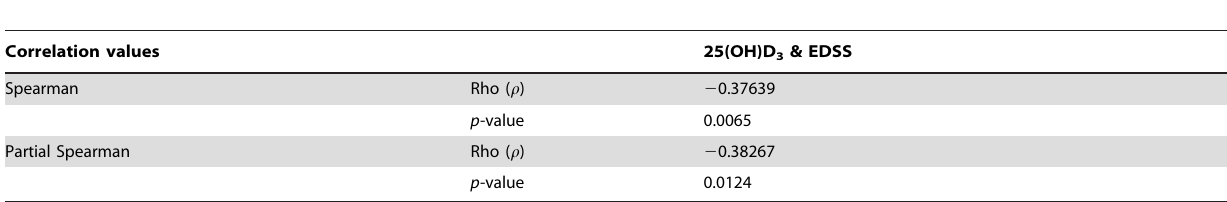
Table 3. Spearman’s correlation analysis for the relationship between 25-hydroxyvitamin D 3 (25(OH)D 3 ) levels and expanded disability status scale (EDSS) score in patients with NMOSD.